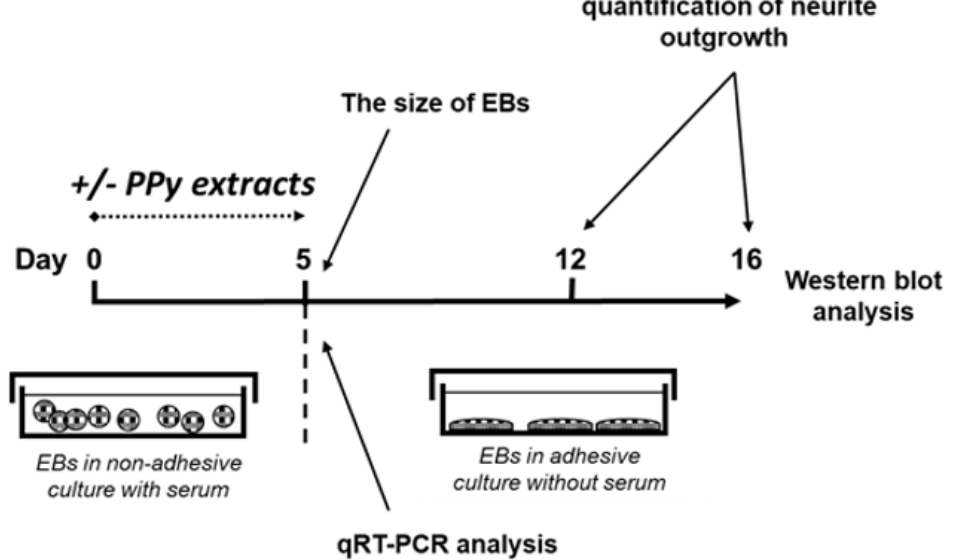
Figure 2. Design of experiment: formation of embryoid bodies in the presence or absence of PPy extracts.